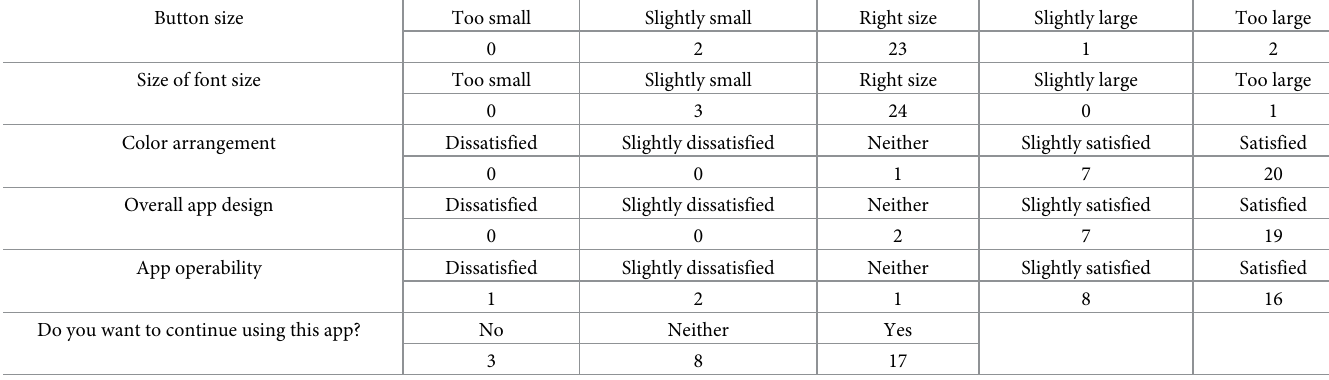
Table 5. Participants’ impressions of the Mental App. Button size